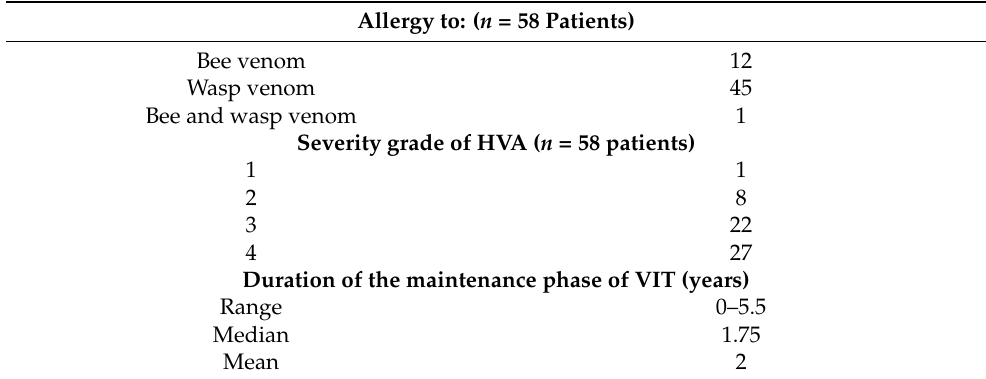
Table 2. Characteristics of study group patients ( n =